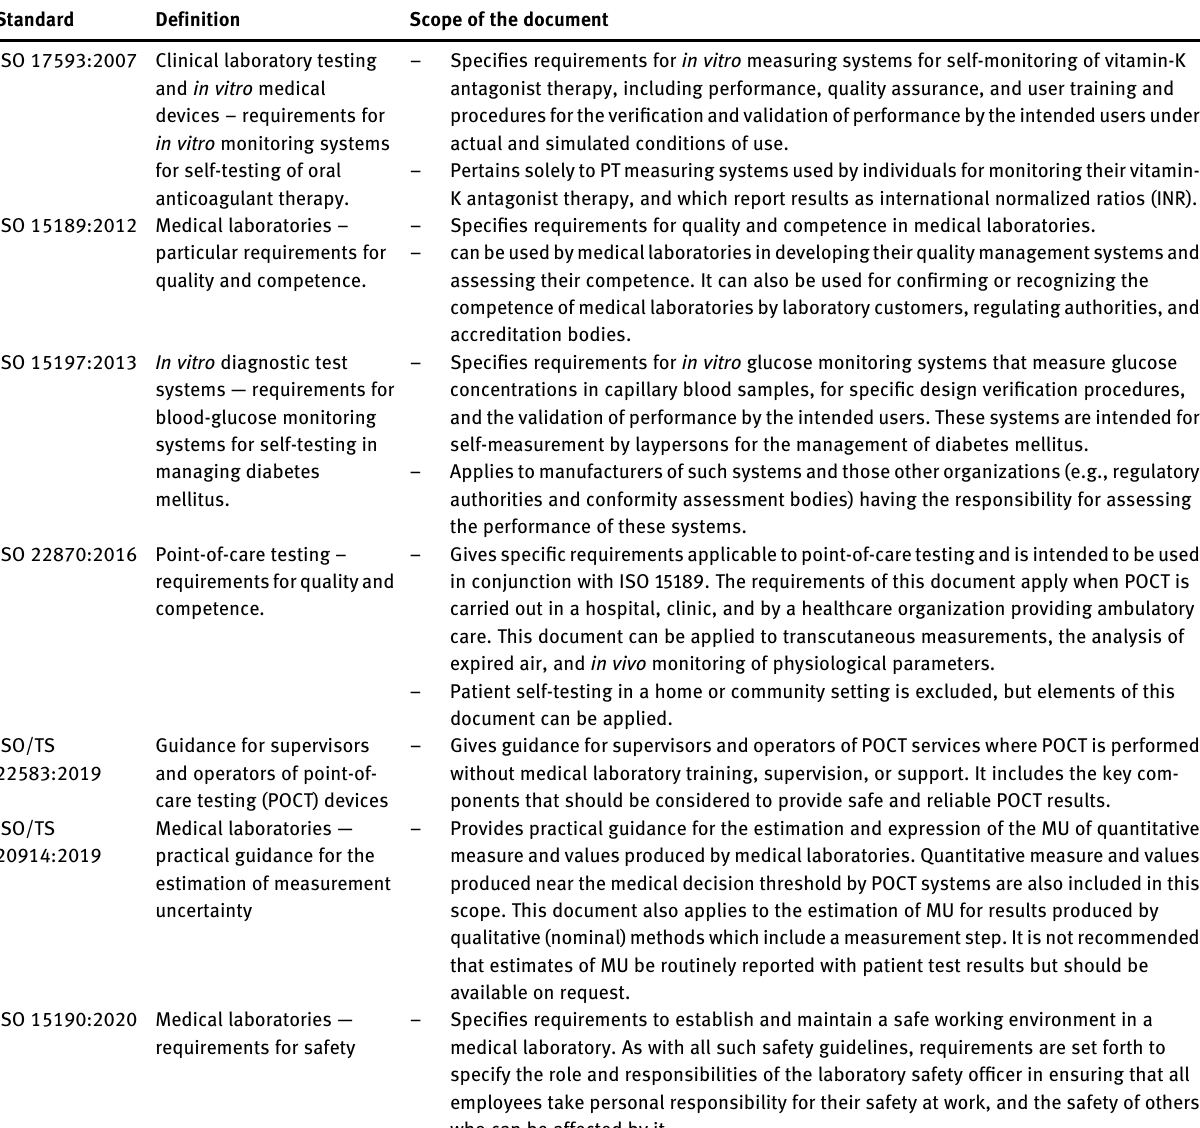
Table  : International standards de fi ne or are associated with medical laboratory and POCT competency and